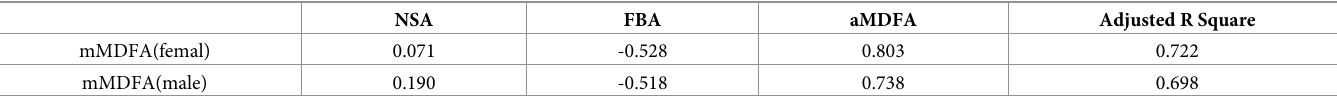
Table 6. Regression test between